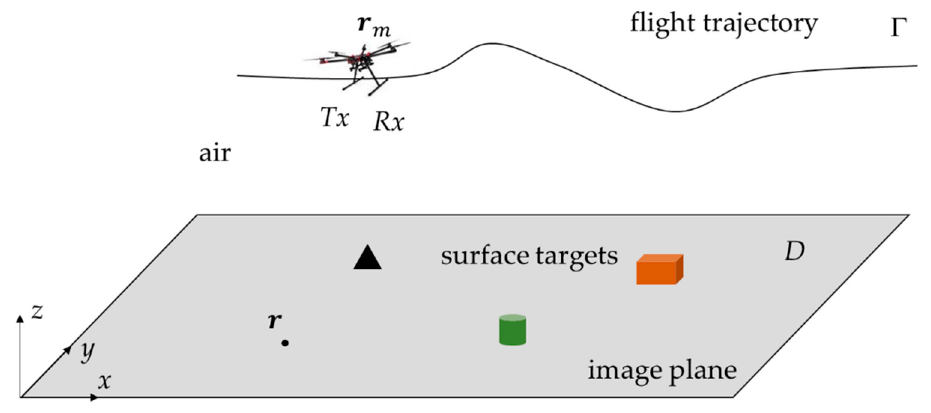
Figure 3. UAV-borne radar imaging scenario.